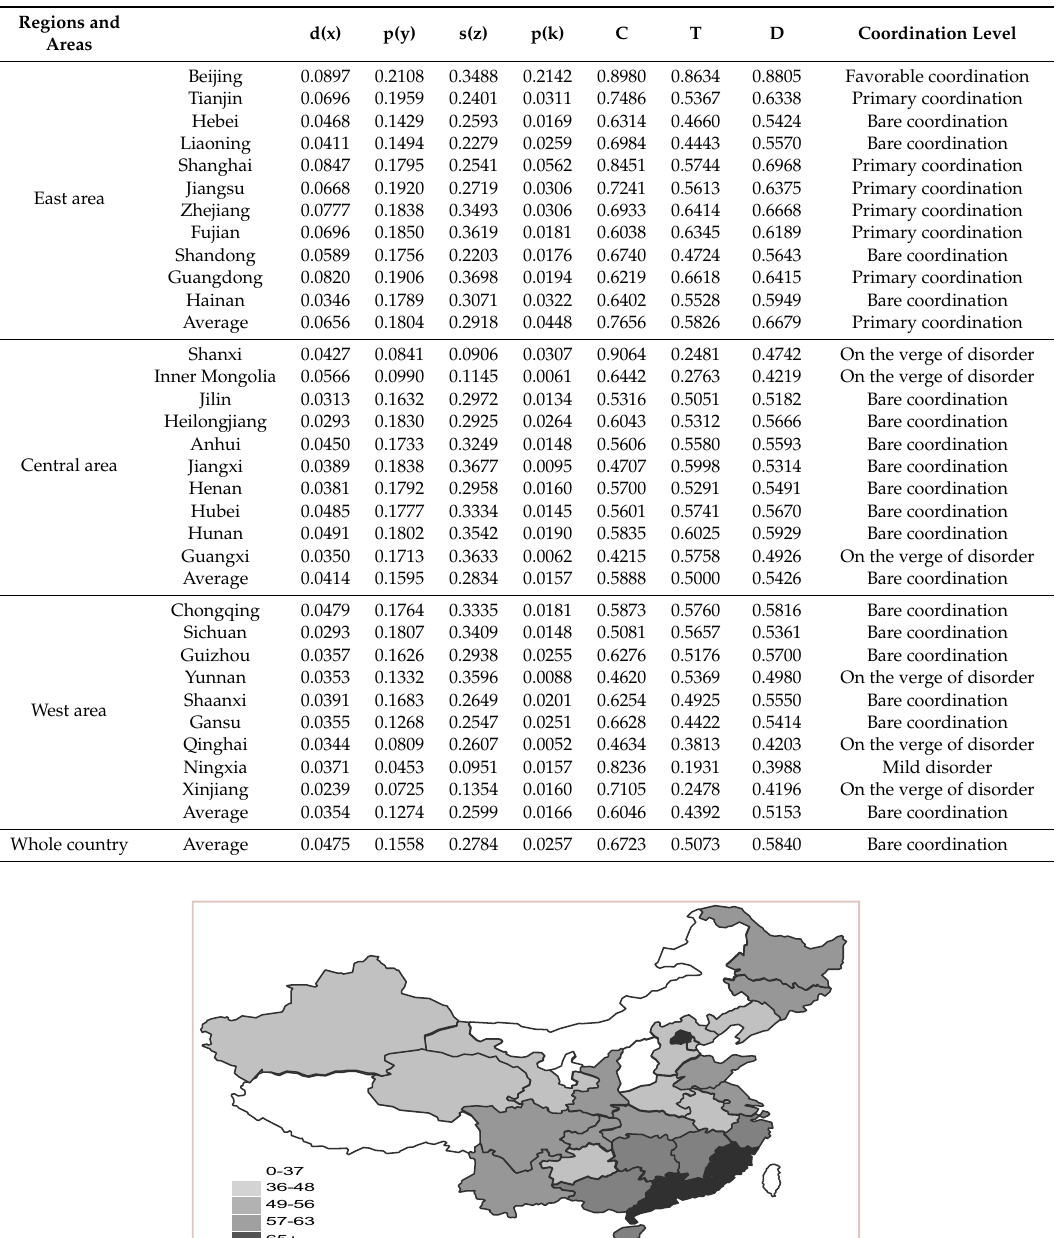
Table 8. The regional comparisons in 2015.